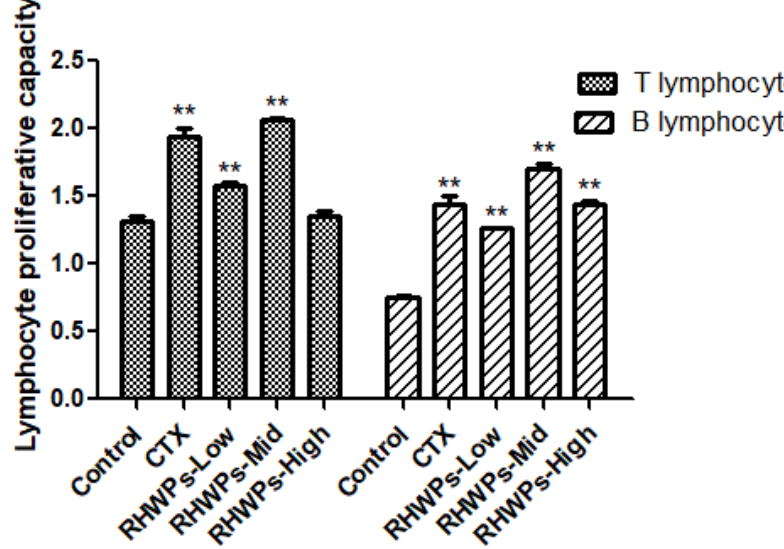
Figure 8. Effect of RHWPs on lymphocyte proliferation in S180 tumor-bearing mice. The splenocytes were isolated and co-cultured with ConA or LPS for 48 h, and the WST-8 approach was used to quantify proliferation. Data are means ± SD ( n = 10), Significant differences from the control groups are designated as ** p < 0.01.